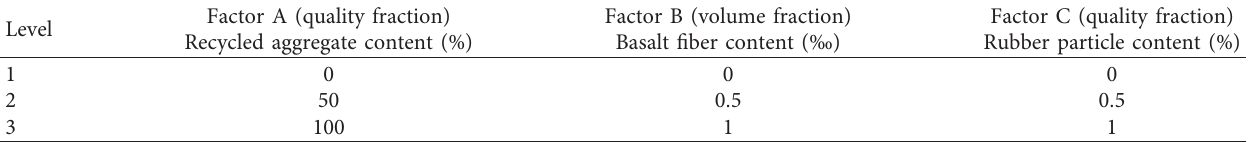
Table 8: Orthogonal test factor-level table.